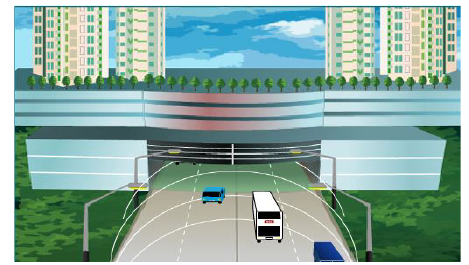
Figure 7 – Tunnels in the function of protection against traffic noise Рис . 7 – Тоннели в качестве защиты от